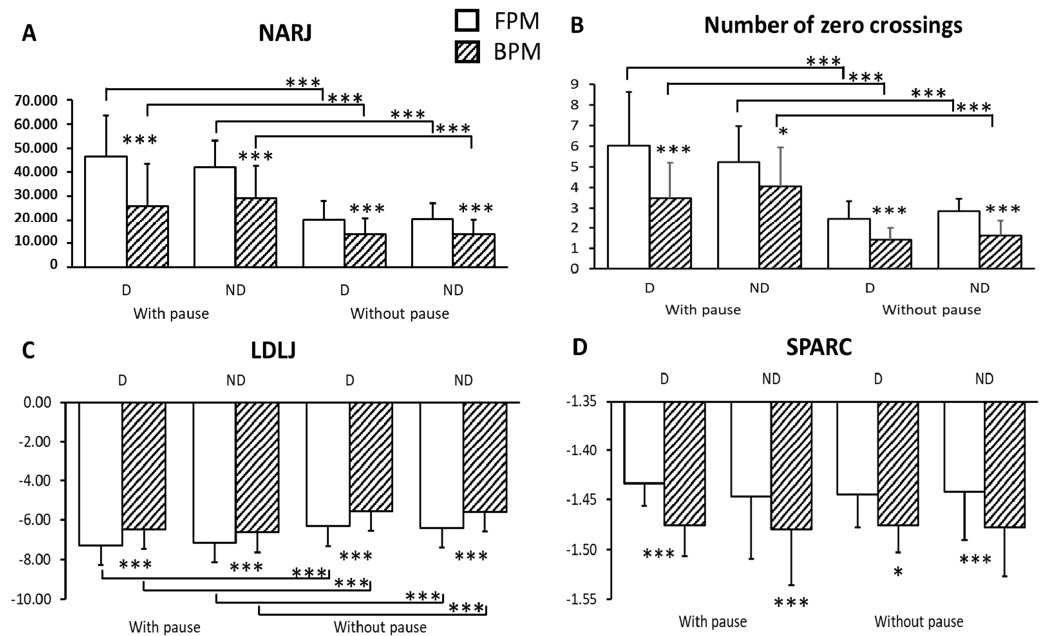
Figure 3. ( A ) Differences in smoothness measured with the NARJ across sides, sets (with pause vs. without pause) and movement type (forward vs. backward). ( B ) Differences in smoothness measured with the Number of Zero Crossings across sides, sets and movement type. ( C ) Differences in smoothness measured with the LDLJ across sides, sets and movement type. ( D ) Differences in smoothness measured with the SPARC across sides, sets and movement type; (Mann–Whitney tests). FPM: forward-pointing movement; BPM: backward-pointing movement; D: dominant, ND: non- dominant; * p < 0.05; *** p <